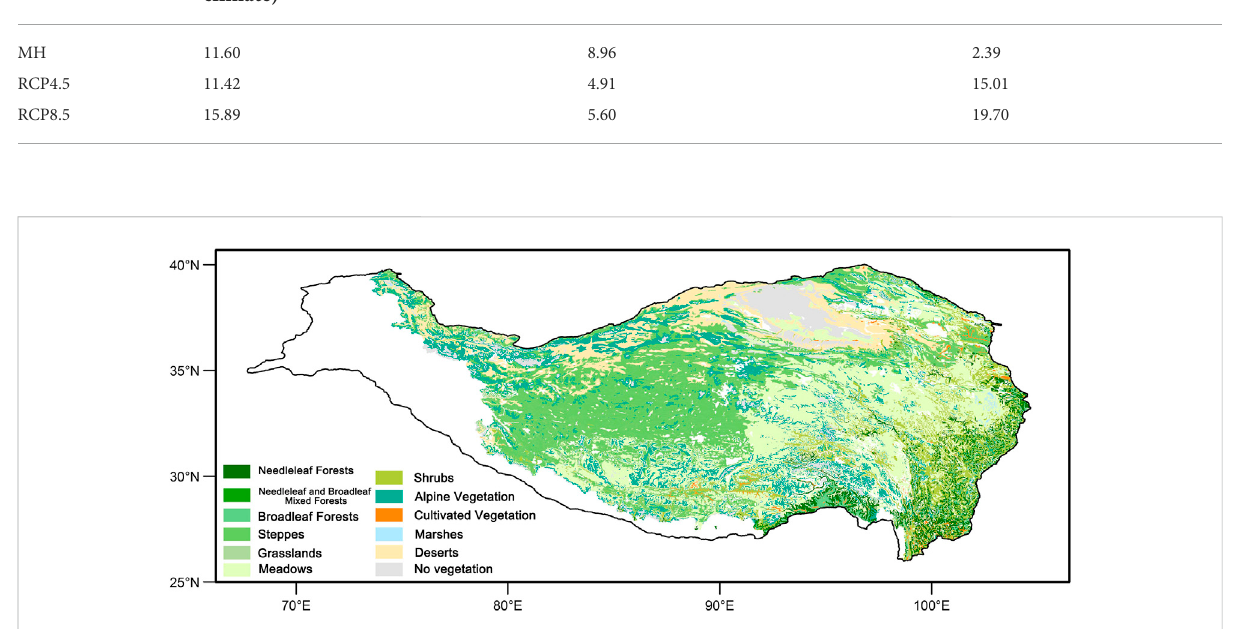
FIGURE 10 Distribution of vegetation types across TP in China during the